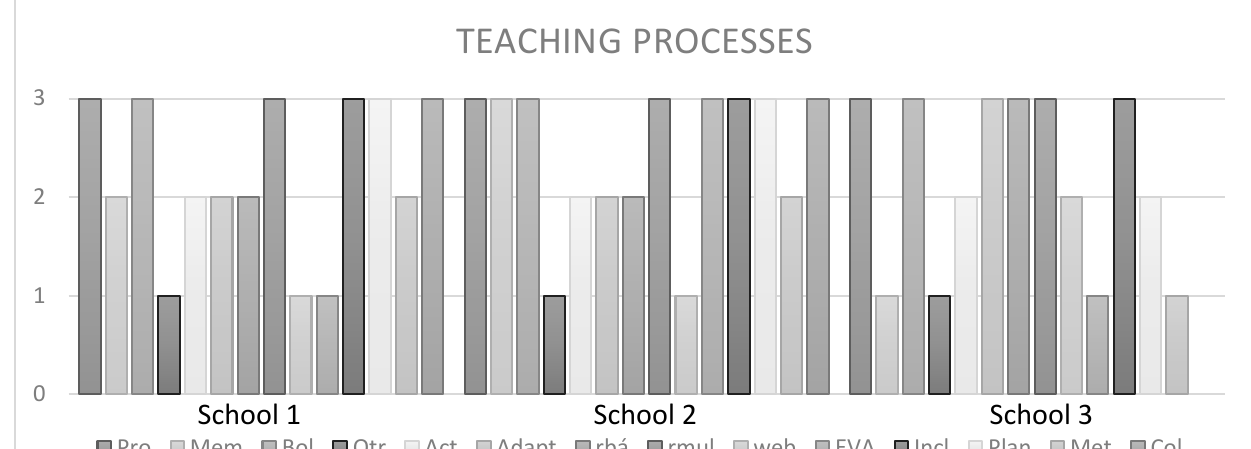
Figure 3. Teaching Processes. Source: author.